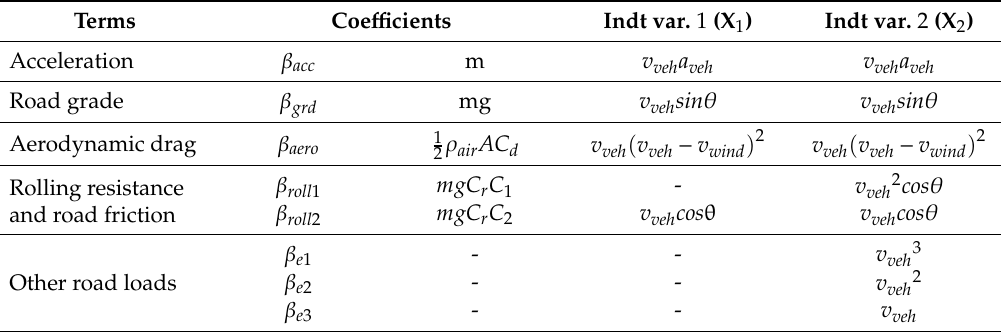
Table 2. Independent-variable (Indt var.) sets for stepwise variation